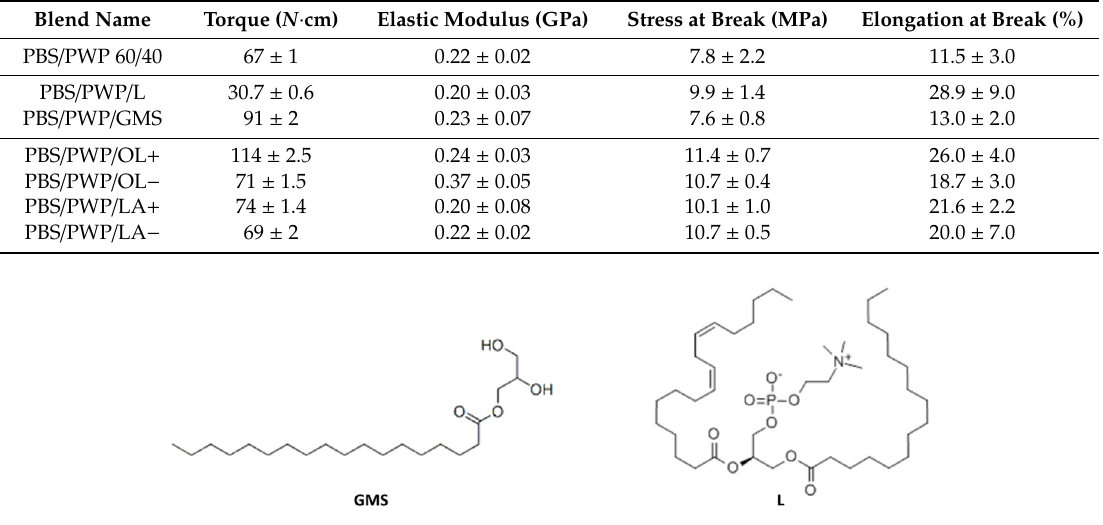
Figure 2. Molecular structure of glyceryl monostearate (GMS) and soy lecithin (L).